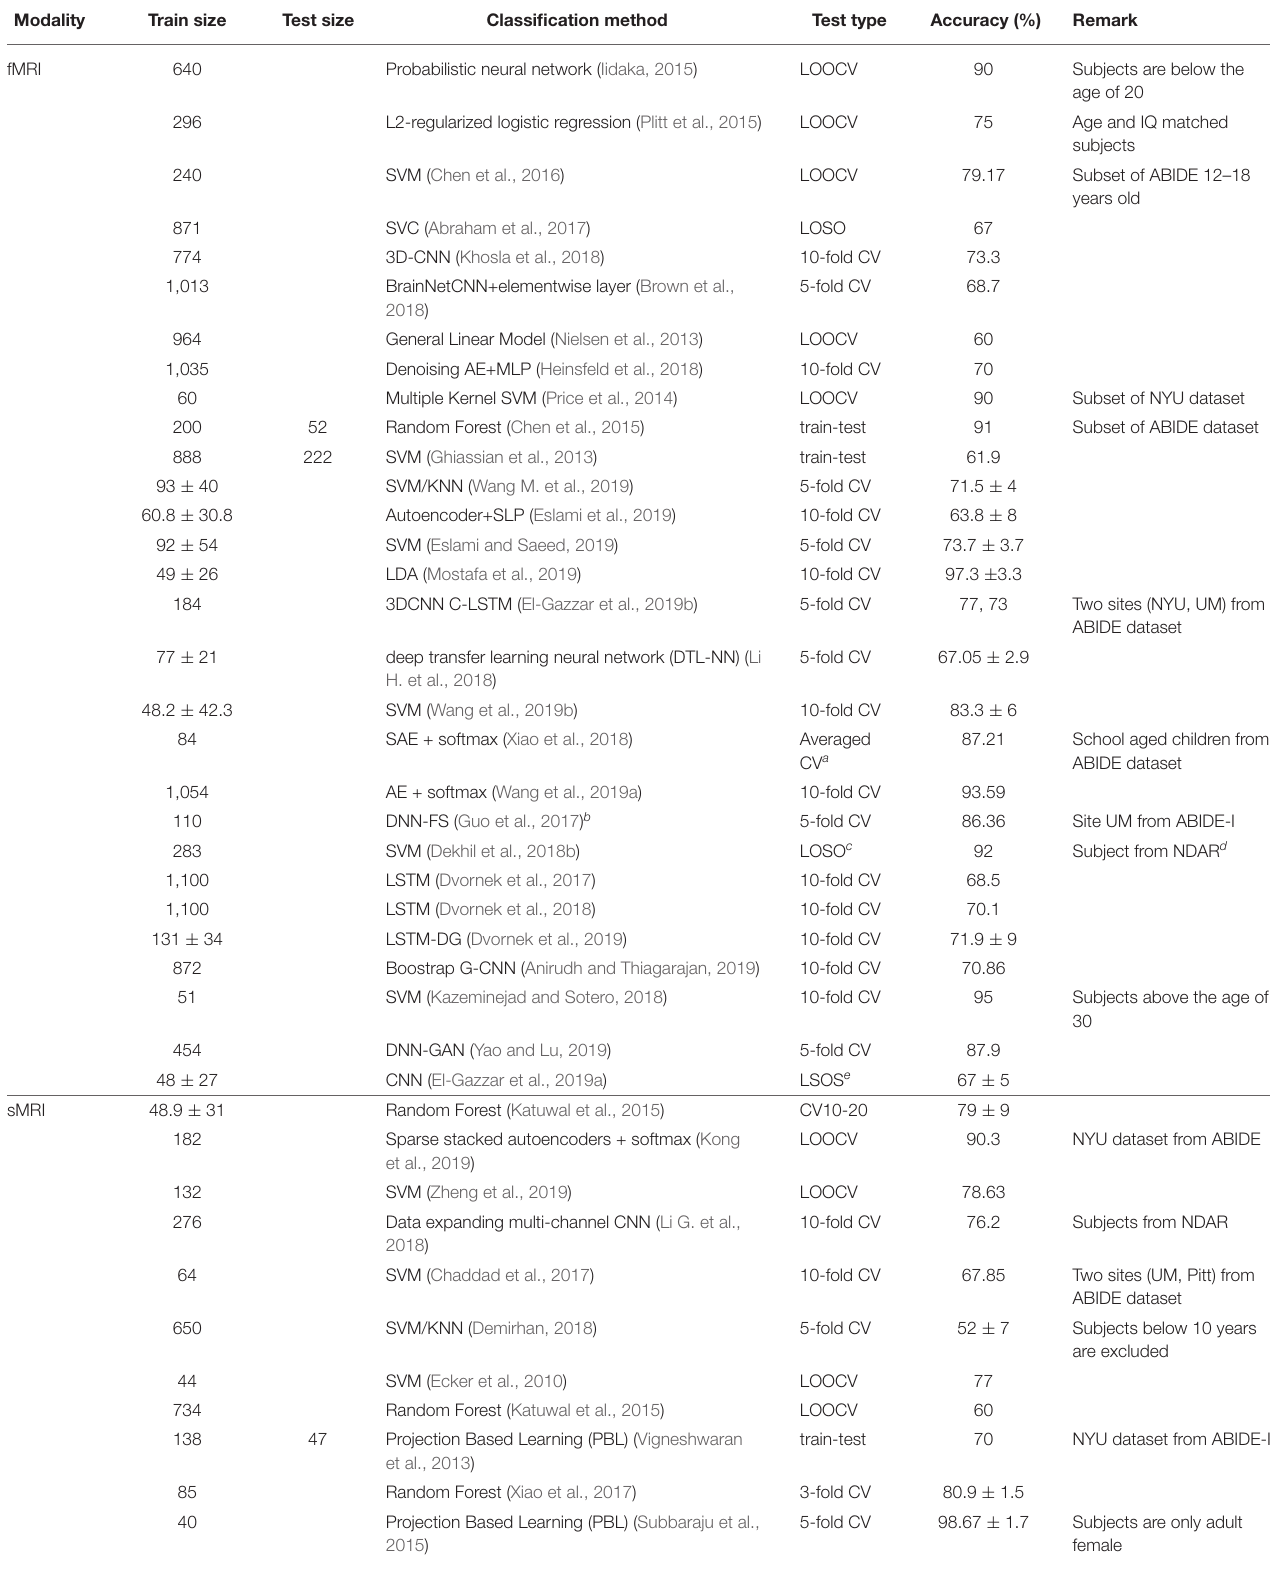
TABLE 1 | Literature review of ASD diagnosis using ML and DL methods is